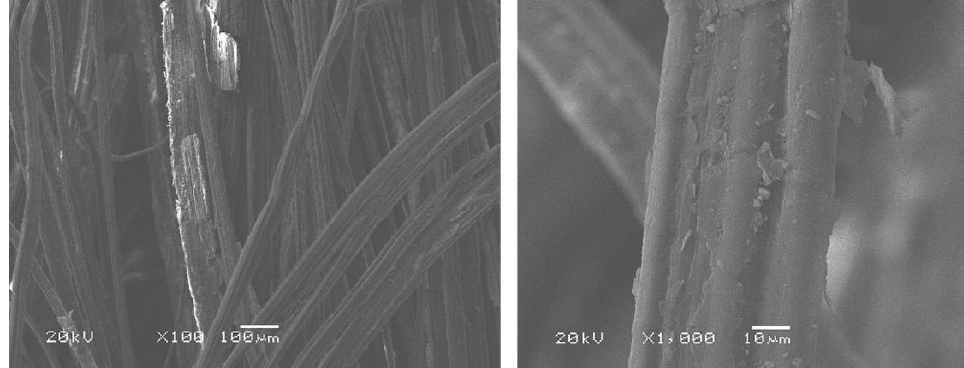
Figure 4. Bundle of nettle fibers under the electron microscope.